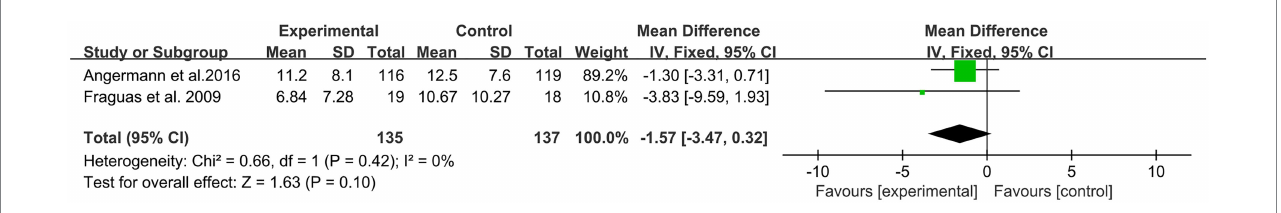
FIGURE 9 Meta-analysis for comparison of MADRS between the experimental and control groups.